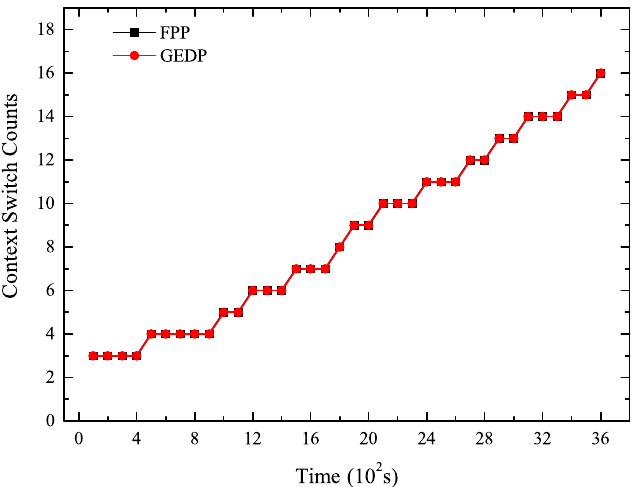
Figure 7. Involuntary context switches of Linpack_bench.